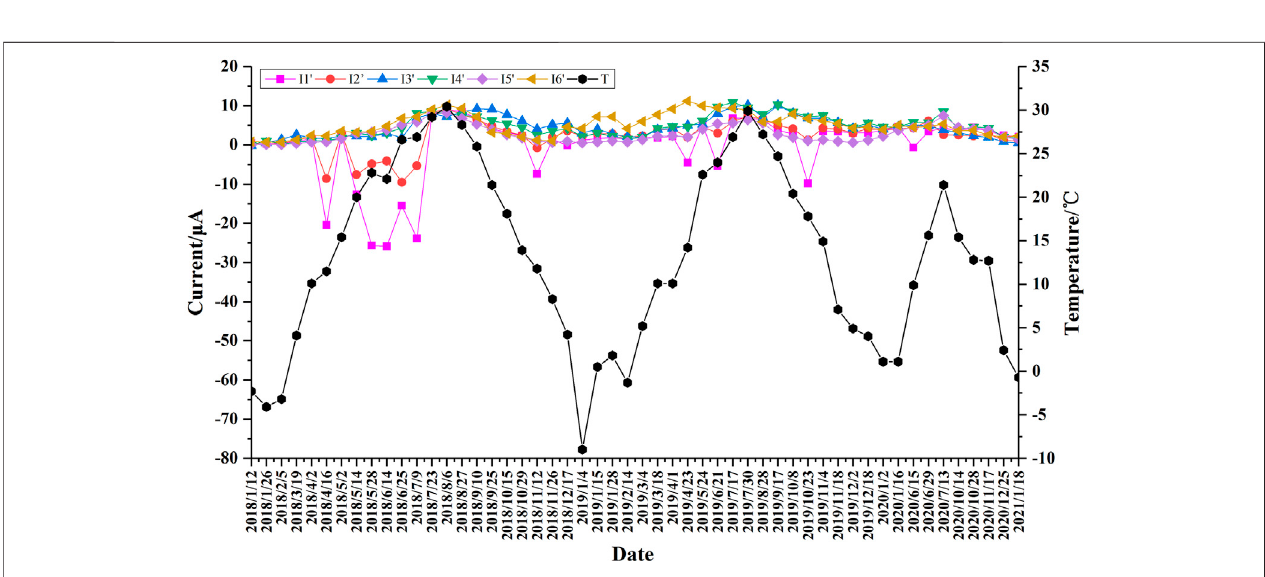
FIGURE 7 | Current between anode and